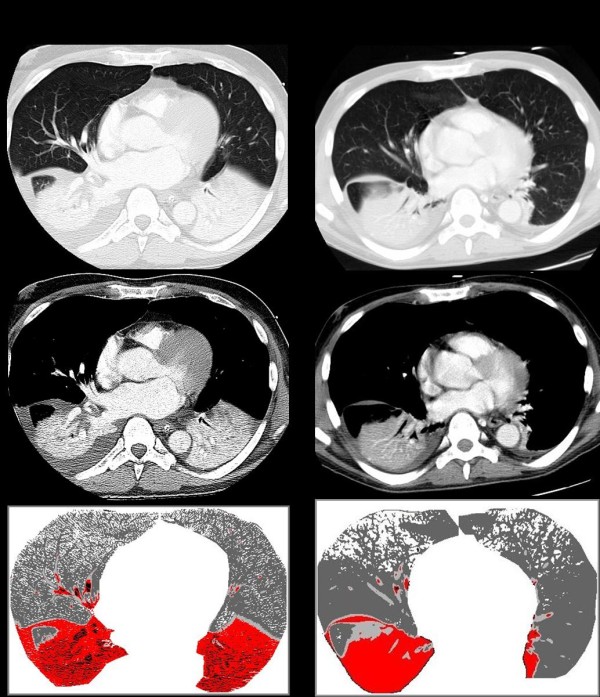
Chest CT performed on Day 3 and Day 37 after the onset of refractory hypoxaemia. a) Chest computed tomography (CT) on Day 3 following the onset of refractory hypoxaemia showing a bilateral consolidation of lower lobes with a right pleural effusion extending to the main fissura (upper CT section, parenchymal window). Large vessels are opacified within each lower lobe consolidation (middle CT section, mediastinal window). The application of a colour encoding system (lower part of the figure) confirms the consolidation of lower lobes [red colour, characterizing nonaerated lung regions with CT attenuations > -100 Hounsfield densities (HU)], shows the hypervascularization of lung consolidations (black colour, characterizing pulmonary vessels containing contrast material with CT attenuations > +200 HU) and evidences the hyperinflation of upper lobes (white colour, characterizing hyperinflated lung regions with CT attenuations < -900 HU). Normally (dark grey colour, characterizing lung regions with CT attenuations ranging between -900 and -500 HU) and poorly aerated lung regions (light grey colour, characterizing lung regions with CT attenuations ranging between -500 and -100 HU) are located to upper lobes. b) The same CT sections obtained at Day 20 following liver transplantation (37 days after the onset of refractory hypoxaemia) showing a persisting consolidation of the right lower lobe without pleural effusion. Large vessels are not anymore opacified within the consolidation (middle CT section, mediastinal window). The application of the colour encoding system (lower part of the figure) confirms the consolidation, the presence of hyperinflated lung regions in upper lobes. It does not show anymore hypervascularization within the right consolidation, suggesting a regression of HPS.